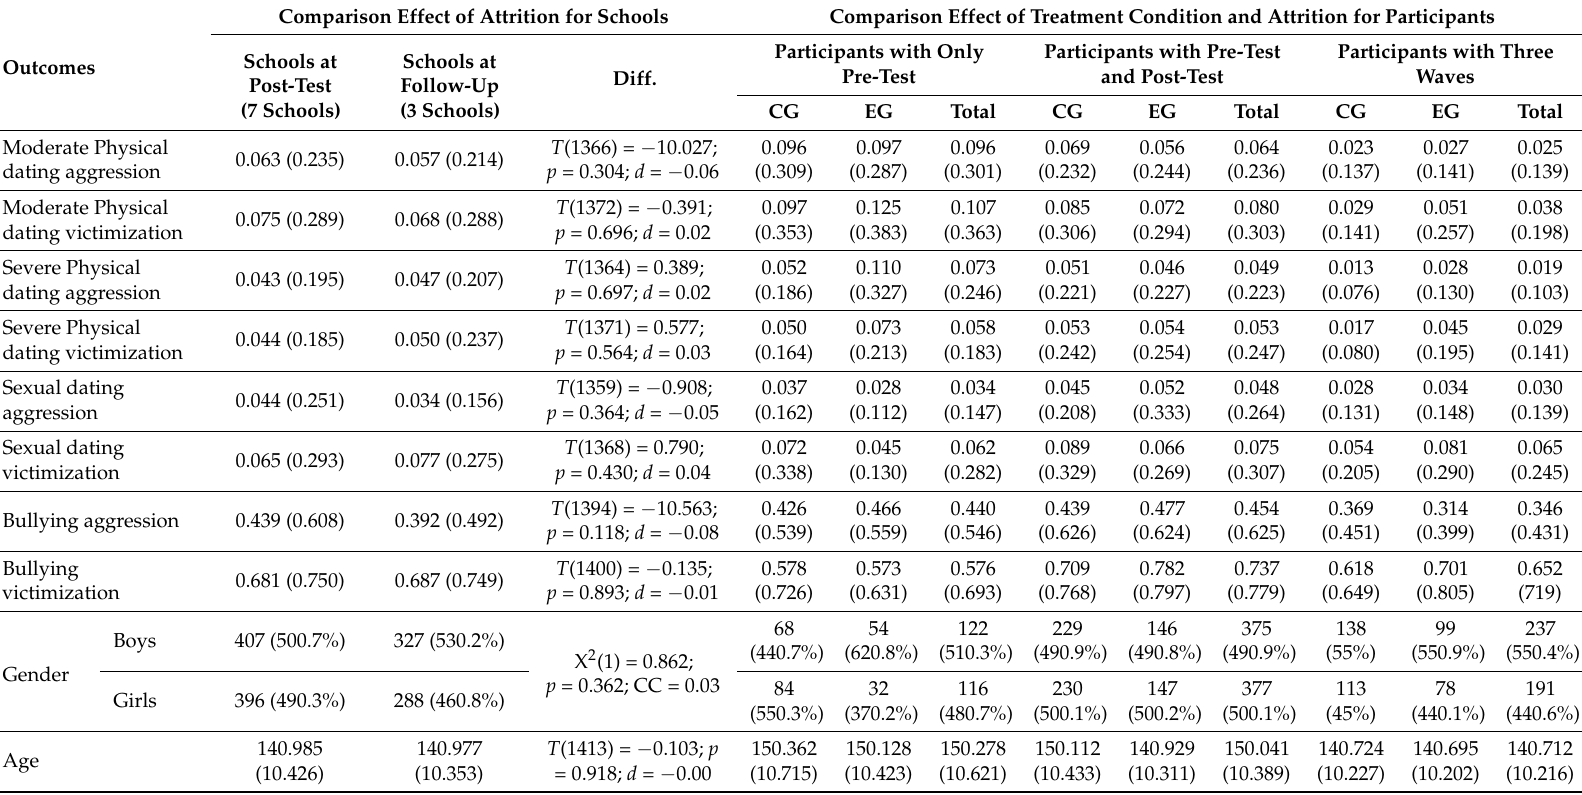
Table 1. Attrition analysis. Comparison effects of attrition at school level and at participant